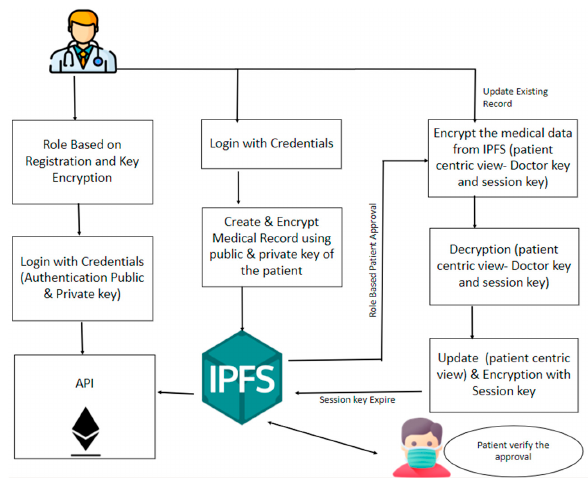
Figure 8. Add records and update records.